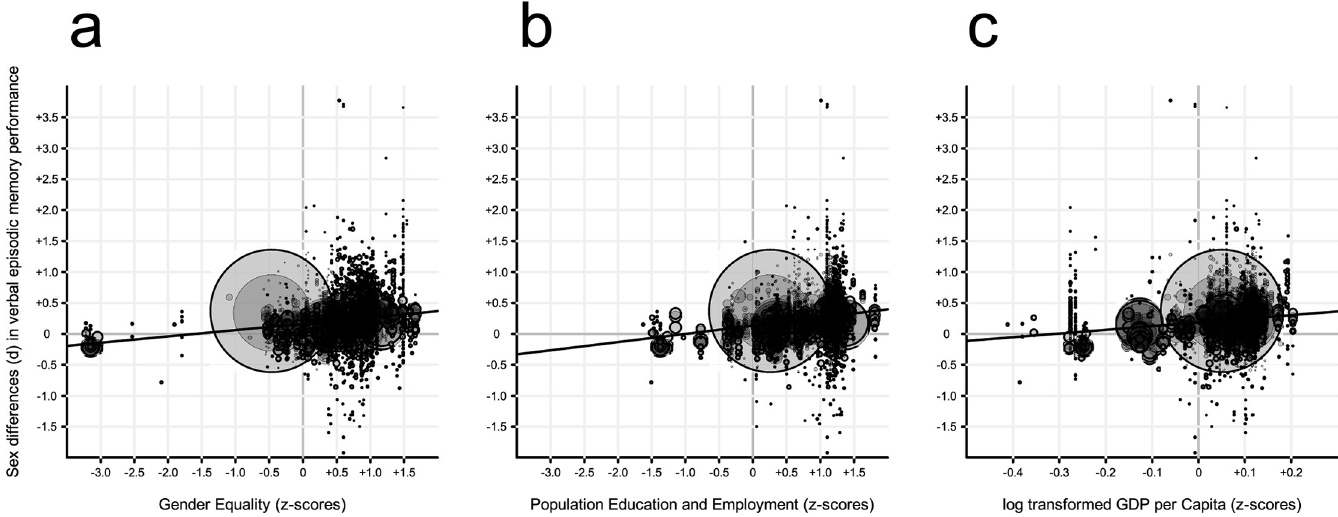
Fig 2. Scatterplots for the three simple effects analyses. Indicator of (a) Gender equality, (b) Population Education and Employment, (c) GDP per Capita (x-axis) plotted against sex differences in Verbal episodic memory performance (y-axis). The diameter of each data point is equal to the inverse of its squared variance. The lines indicate the best-fitting